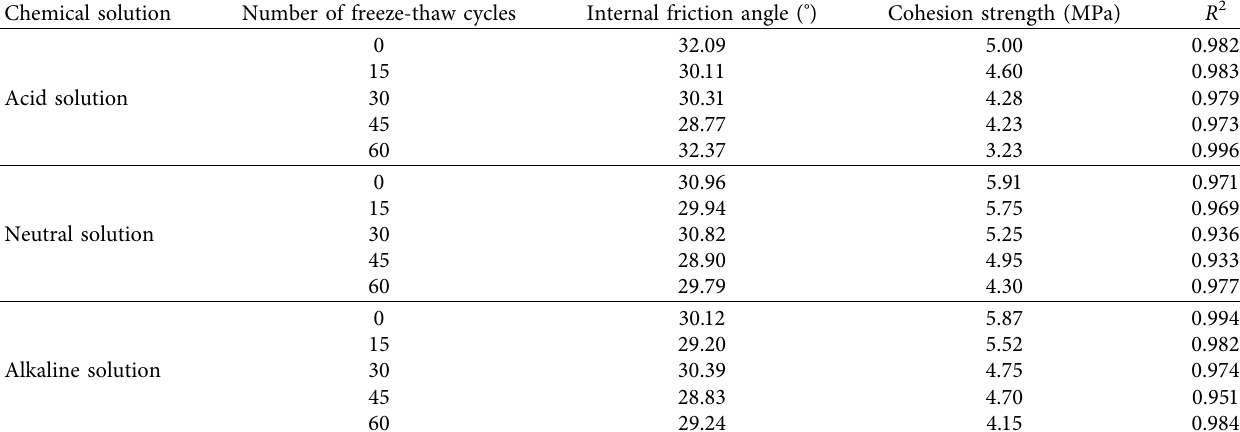
Table 3: Internal friction angle and cohesion strength of sandstone samples under the coupling action of chemical solution erosion and freeze-thaw cycles.